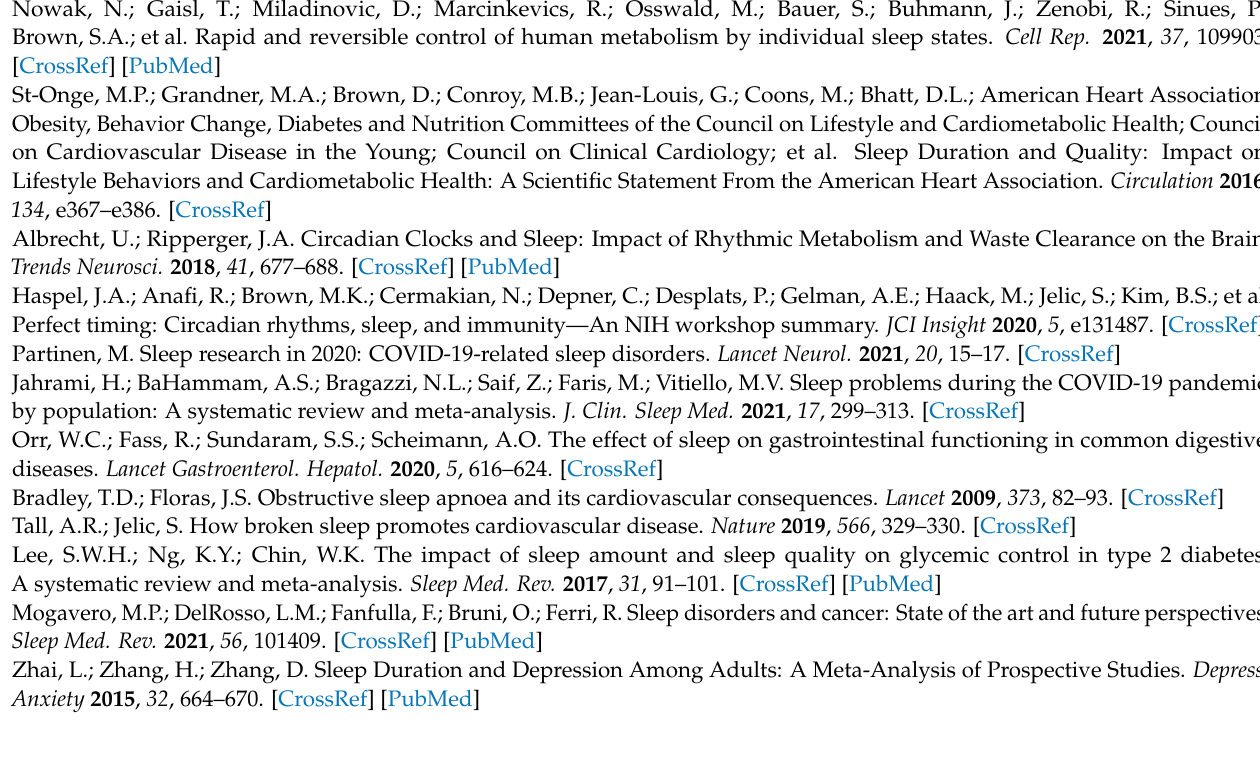
covariates. Table S2: Weighted odds ratios (95% confidence intervals) for day sleepiness across Table S3: Weighted odds ratios (95% confidence intervals) for other sleep quality problems across Table S4: Weighted odds ratios (95% confidence intervals) for other sleep quality problems across Table S5: Weighted relative risk ratios (95% confidence intervals) for sleep duration (reference, 7 ≤ 9 h/night) across quartiles of pyridoxal 5 (cid:48) -phosphate (PLP) concentrations stratified by gender (NHANES 2005–2010). Table S6: Weighted relative risk ratios (95% confidence intervals) for sleep duration (reference, 7 ≤ 9 h/night) across quartiles of pyridoxal 5 (cid:48) -phosphate (PLP) concentrations stratified by age (NHANES